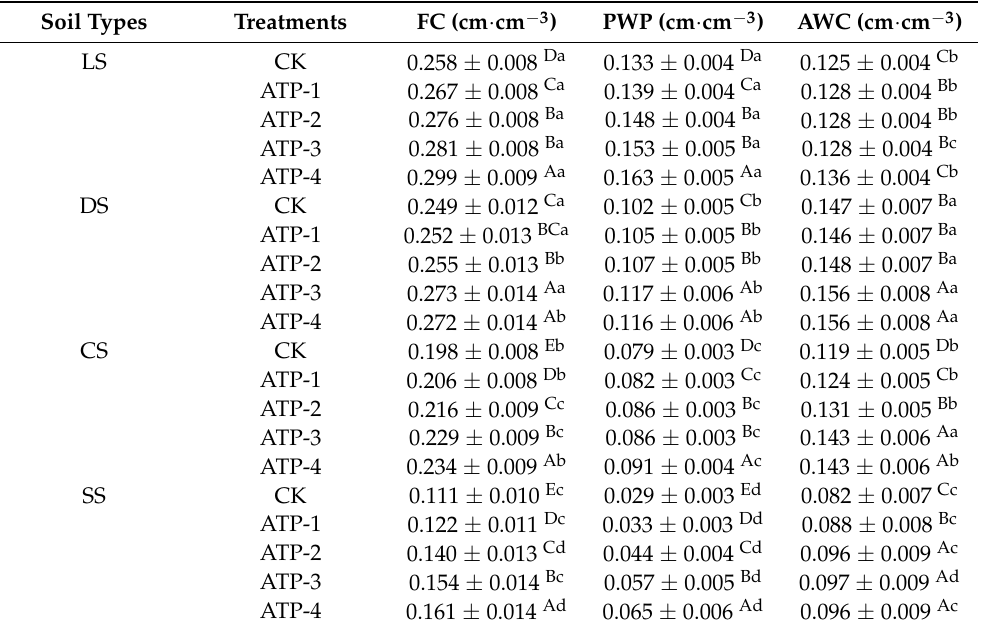
Table 4. Soil physical properties of lou soil, dark loessial soil, cultivated loess soil, and sandy soil obtained from the soil water retention curve.